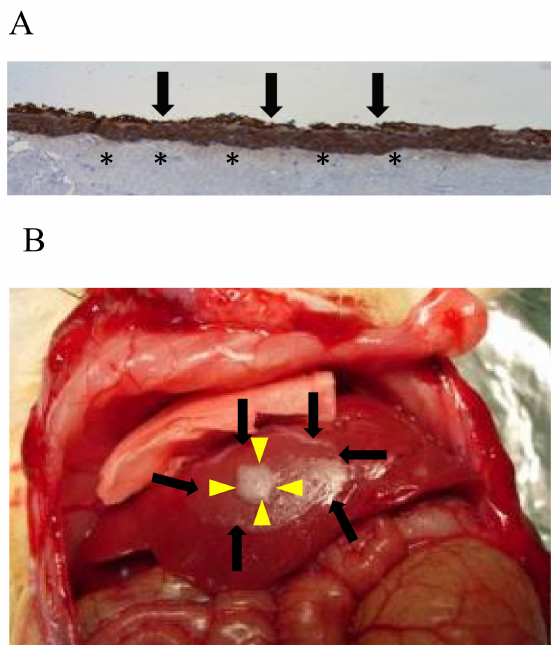
Figure 1. The cytokeratin AE1/AE3 staining of the keratinocyte sheet used in the present study ( A ), and photograph of transplanted rat islets on liver surface using the keratinocyte sheet ( B ). Ker- atinocyte sheets (black arrows) cultured on collagen gel containing fibroblasts (asterisks) were placed on the liver surface to cover islet grafts (yellow